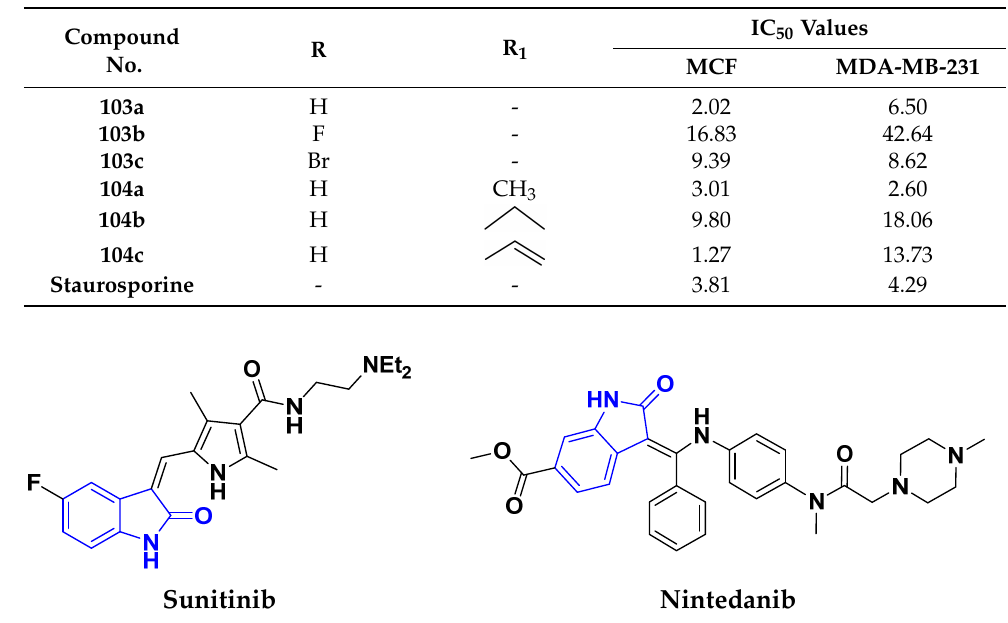
Figure 99. The isatin moiety as FDA ‐ approved anticancer drug.